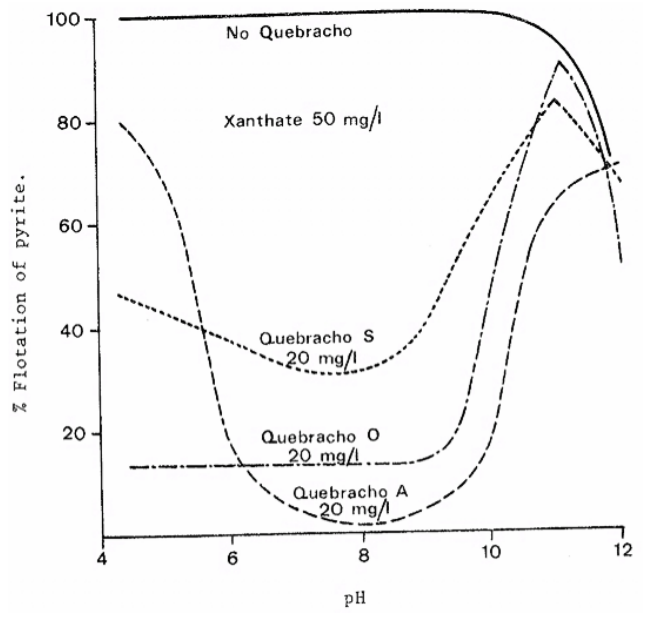
Figure 4. Depression of non-oxidized pyrite with addition of xanthate and quebracho [3].